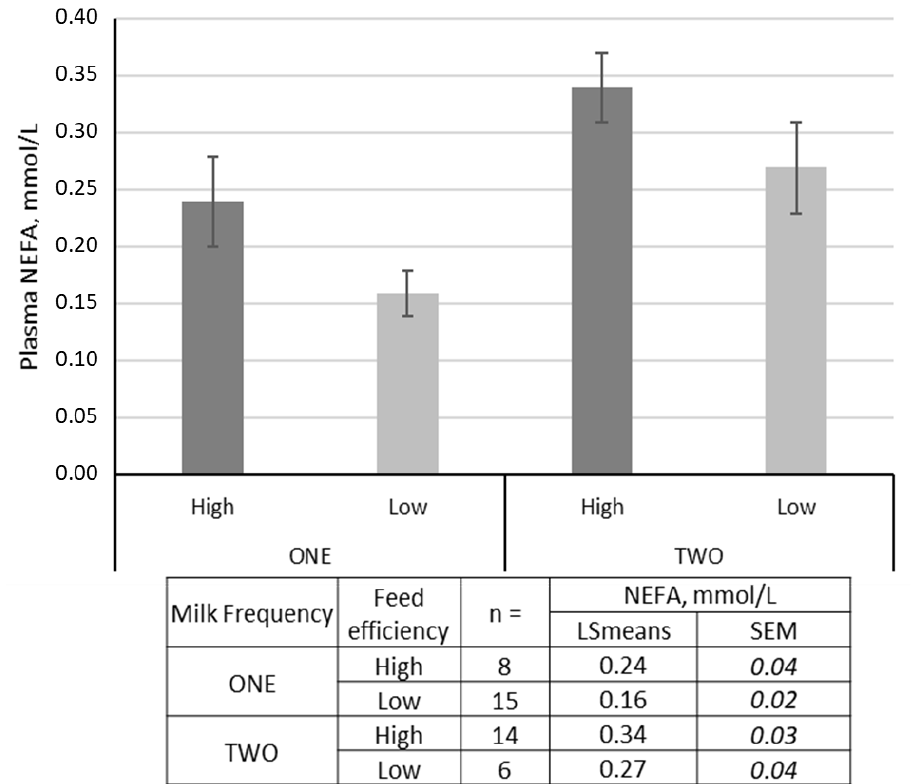
Figure 3. Relationships between the daily milking frequency to which the ewes were subjected (ONE vs. TWO), the ewes’ feed efficiency classification (High vs. Low) and the body reserves mobilization illustrated by the plasma non-esterified fatty acids (NEFA) concentration.